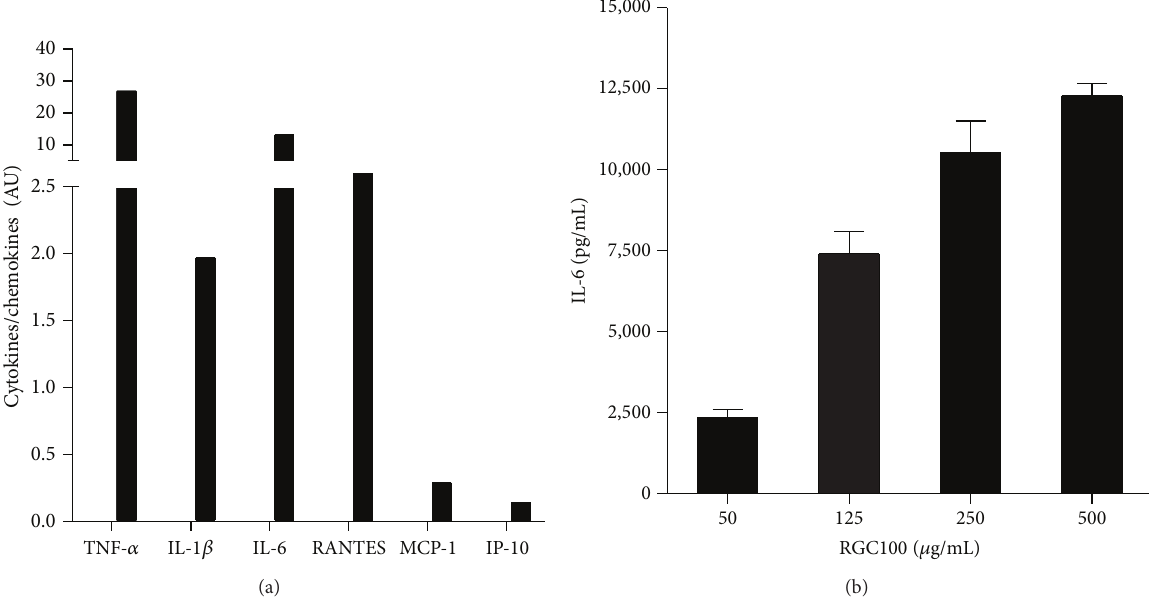
Figure 3: Activation of JAWS II DCs by RGC100 in a dose-dependent manner. (a), cytokine and chemokine profile of JAWS II DCs activated by RGC100. RGC100 was incubated with JAWS II DCs for 16h at a concentration of 250 𝜇 g/mL. Secretion of cytokines was measured by ELISA. Negative control consists of supernatant of cells incubated in the absence of RGC100. Values of negative control have been subtracted from the values represented on the graph. Values shown are mean ± SEM of two independent measures. (b), Dose-dependent activation of JAWS II DCs by RGC100. RGC100 was incubated with cells for 16h at the indicated concentrations. Secretion of IL-6 was measured by ELISA. Values shown are mean ± SEM of two independent measures. Negative control consists of supernatant of cells incubated in the absence of RGC100. Values of negative control have been subtracted from the values represented on the